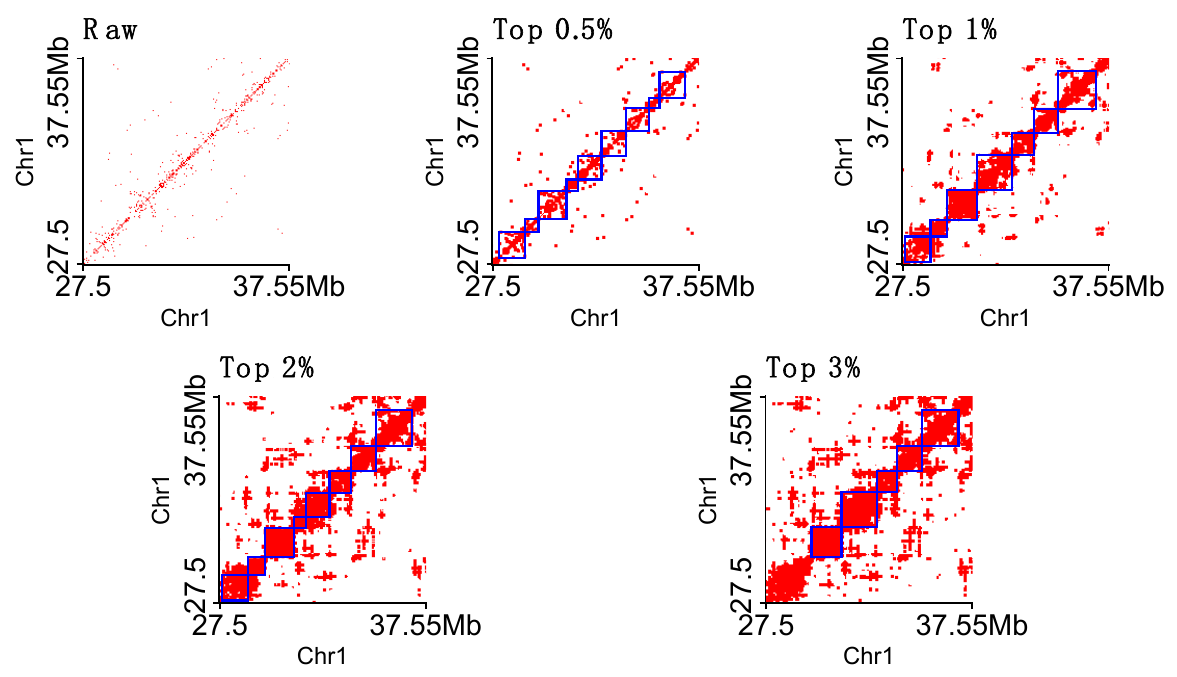
Figure 8. TAD examples at 50 kb resolution called on raw and imputed (four different top t param ‐ eters) single ‐ cell Hi ‐ C. The blue lines highlight TADs.